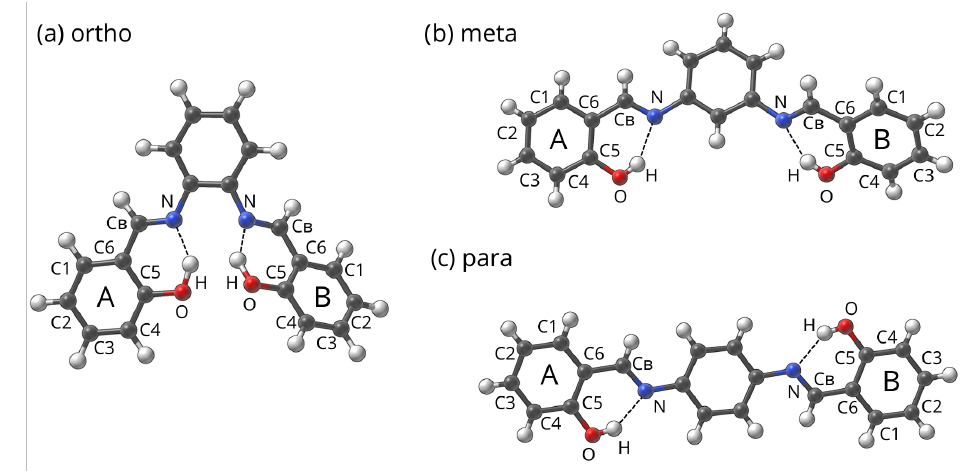
Figure 12. Base structures of studied compounds (( a ) [95], ( b ) [69], ( c )